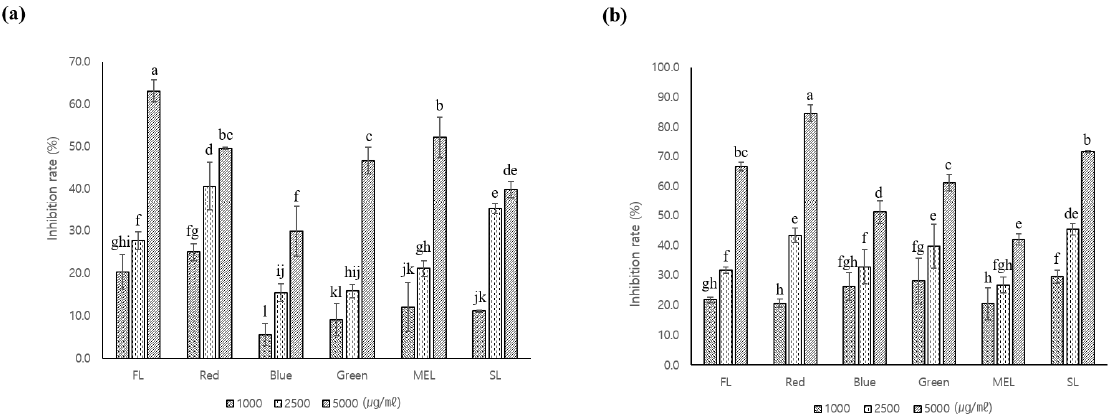
Figure 4. The inhibition rate of tyrosinase of aerial ( a ) and underground ( b ) parts from extracts of A. macrocephala under different light sources. Significance was indicated with different letters according to statistical